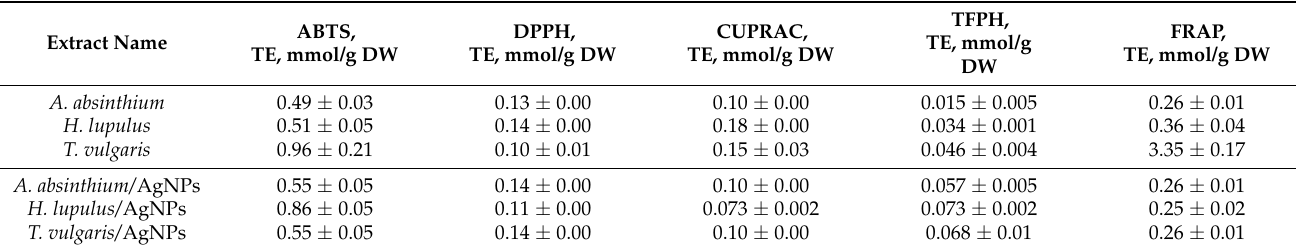
Table 2. Antioxidant activity of extracts and extracts/AgNPs.